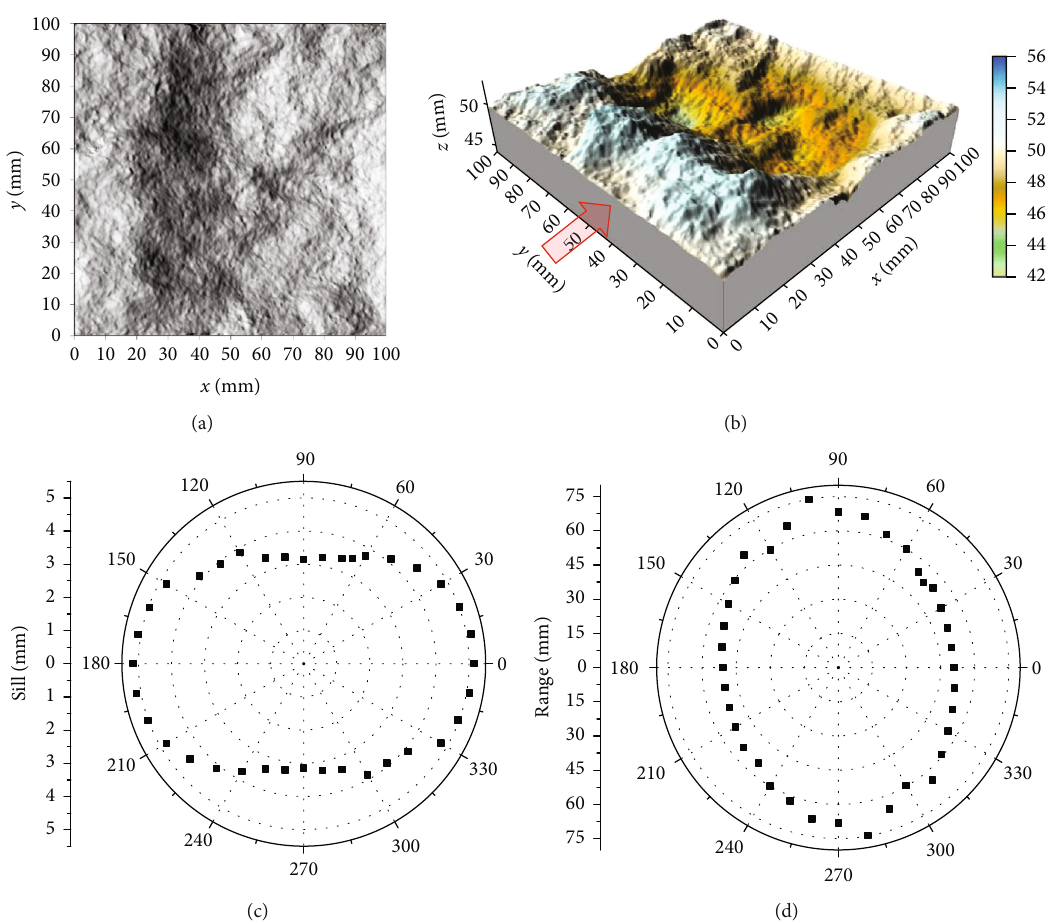
Figure 6: Parameter distribution curve of the variogram at a water content of 100%: (a) contour map, (b) 3D map, (c) sill, and (d) range (red arrow represents the direction along the x -axis and the position of the load